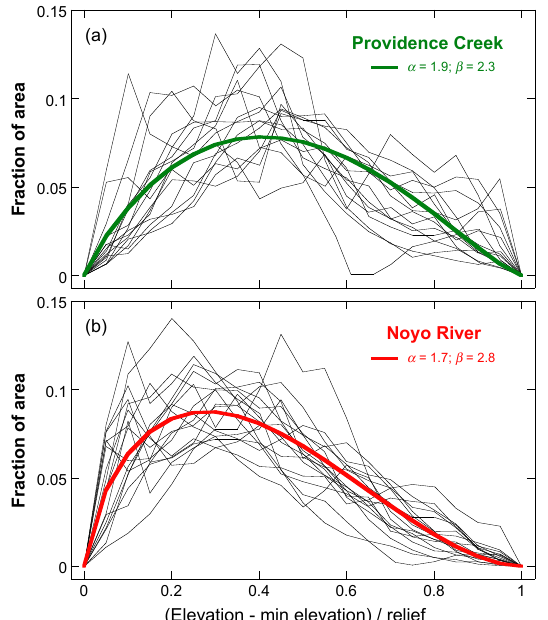
Figure 11. Normalized distribution of elevation by travel dis- tance bin for other catchments. Travel distance and elevation bin sizes = 1/20 of maximum values. Thin lines show elevation dis- tributions, normalized by local relief, for each travel distance bin. Thick colored curves show best-fit beta distributions, with shape parameter values indicated. Normalized elevation distributions are more skewed for Noyo River, reflecting larger drainage area and greater degree of landscape